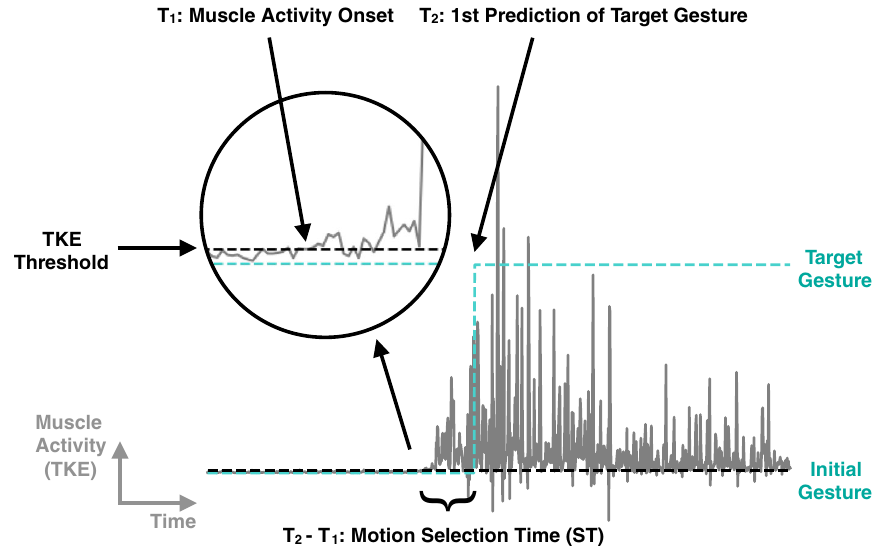
Figure 4. Motion onset detection with the Teager-Kaiser Energy (TKE) operator. The operator is used to monitor muscle activity and define a threshold to detect the onset of motion. The time from the onset to the new target prediction is referred to as the motion selection time (ST). This is the time it takes for the user to execute a target gesture and the algorithm to update its output accordingly.